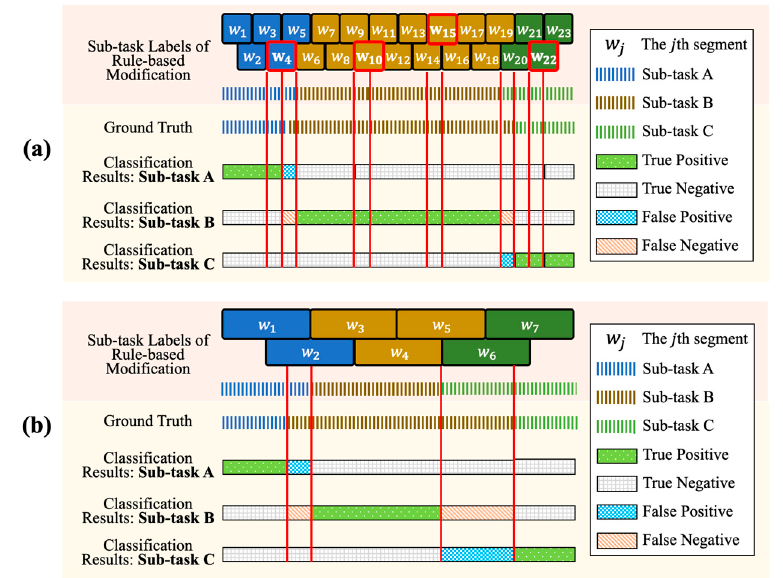
Figure 9. An illustration of the segmentation performance using smaller and larger window sizes. ( a ) The classification results using smaller window size, where the window size is 0.5 s. ( b ) The classification results using larger window size, where the window size is 1.5(cid:1871) .